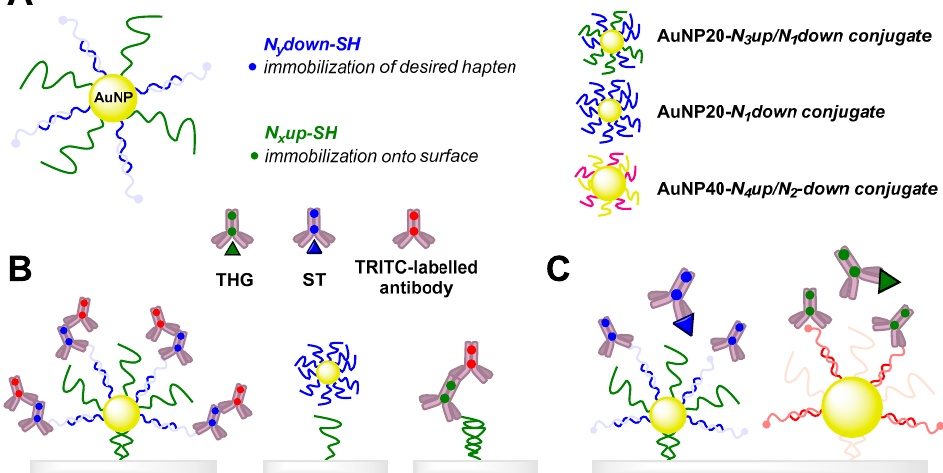
Figure 8. A diagram depicting the composition of multifunctional biohybrid nanoparticles. ( A ): A nanoparticle (NP) is codified with two different oligonucleotide strands: one for selective function- alization with the corresponding hapten, and the second for immobilization on a DNA microarray. The oligonucleotides are designated as Nx plus the words down or up. The “down” series hybridize with the corresponding hapten–oligonucleotide conjugate with the complementary oligonucleotide sequence. The “up” series hybridize with the complementary oligonucleotide sequence immobilized on the DNA microarray chip for site codification of the gold nanoparticles (AuNPs). AuNP20- N 3 up/ N 1 down (20 nm-sized NPs) detect stanozolol (ST) with N 3 upSH, which is complementary to N 3 downNH 2 oligonucleotides immobilized on the chip, and N 1 down, complementary to the hapten oligonucleotide probe 8- N 1 up. AuNP20- N 1 down does not have a chain that hybridizes with the DNA chip. AuNP40- N 4 up/ N 2 down (40 nm-sized NPs) detect tetrahydrogestrinone (THG) and are biofunctionalized with N 4 upSH for hybridization with the N 4 downNH 2 chains of the DNA chip, and with N 2 downSH for hybridization with the hapten oligonucleotide probe hG- N 2 up). Selectivity of the DNA-directed immobilization of AuNPs is demonstrated by fluorescence immunoassay and the multiplexed localized surface plasmon resonance microarray chip for the determination of ST and THG. ( B ): the diagram shows the experimental conditions for each case of the oligonucleotide-codified AuNPs, the antibodies used, and the multiplexed LSPR immunosensor chip. ( C ): specific antibodies bind to their corresponding hapten immobilized on the surface of the chip, or to a free analyte